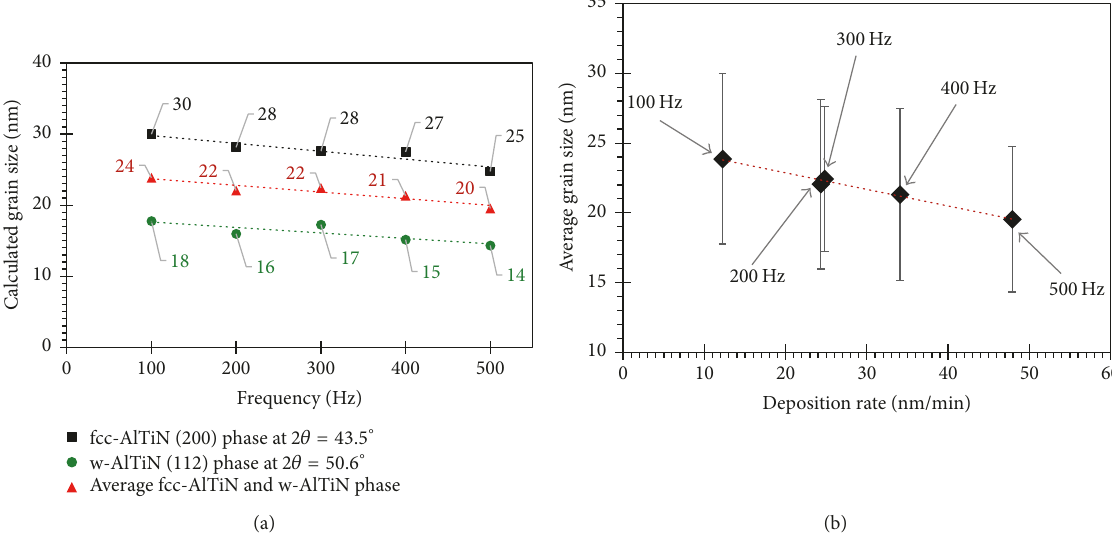
Figure 6: Calculated grain size by Debye-Scherrer formula and linear regression functions (a) of the fcc-AlTiN phases (black data points), the w-AlTiN phases (green data points), and the averaged grain size of both phases (red data points). (b) shows the average grain size of fcc-AlTiN and w-AlTiN as a function of the deposition rate at different pulse-frequencies in the range of 100–500